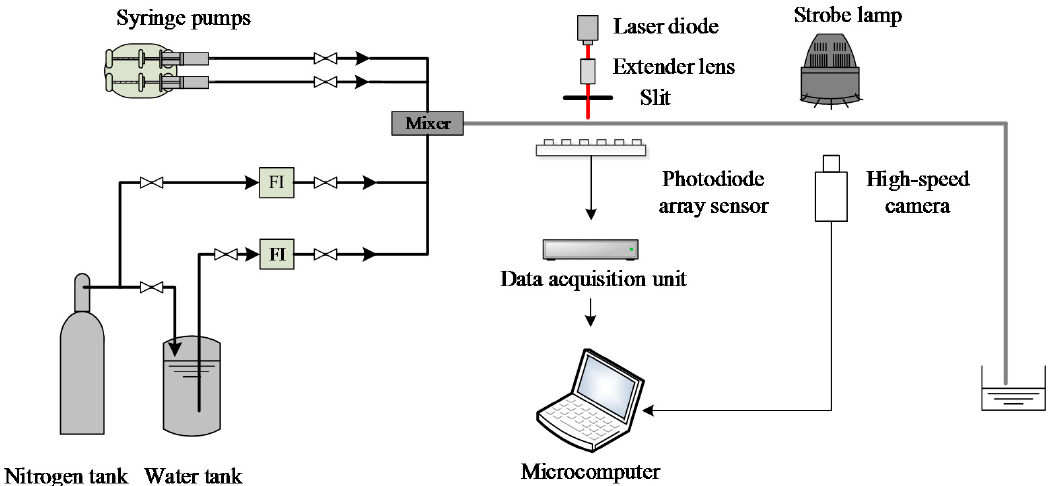
Figure 7. Experimental setup of the void fraction measurement system for gas-liquid two-phase flow in small channels.